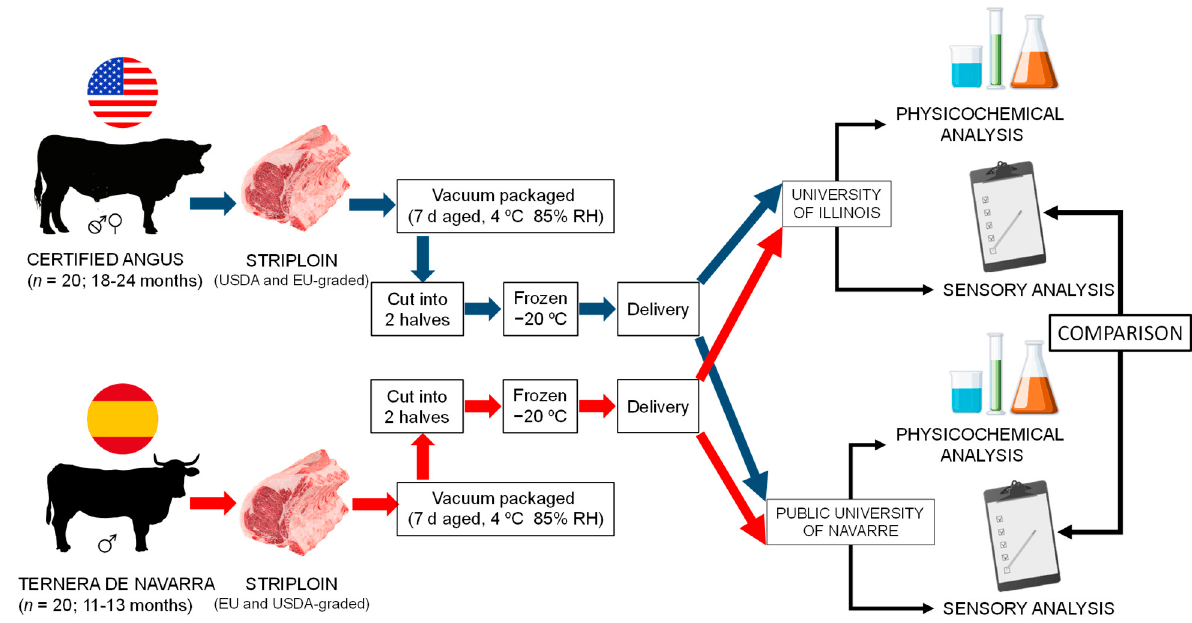
Figure 1. Illustration for experimental design of current study.